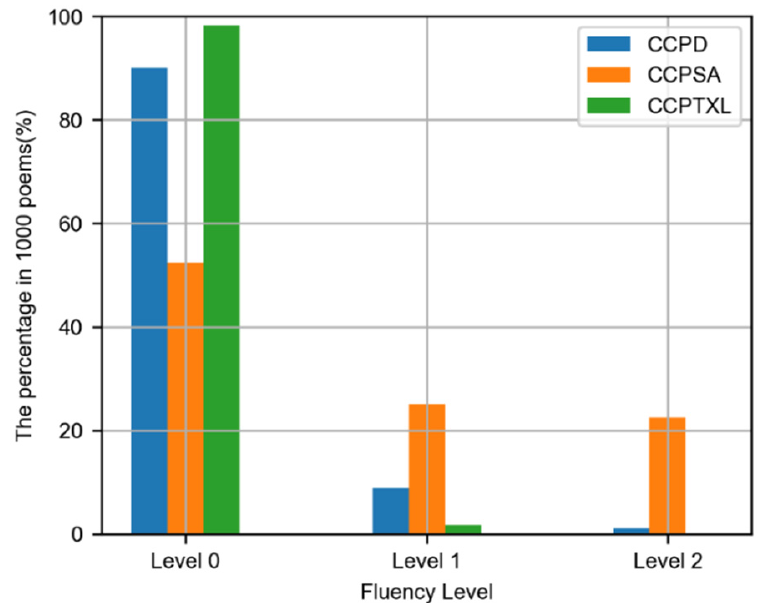
Figure 4. The distribution of fluency level of poem datasets.